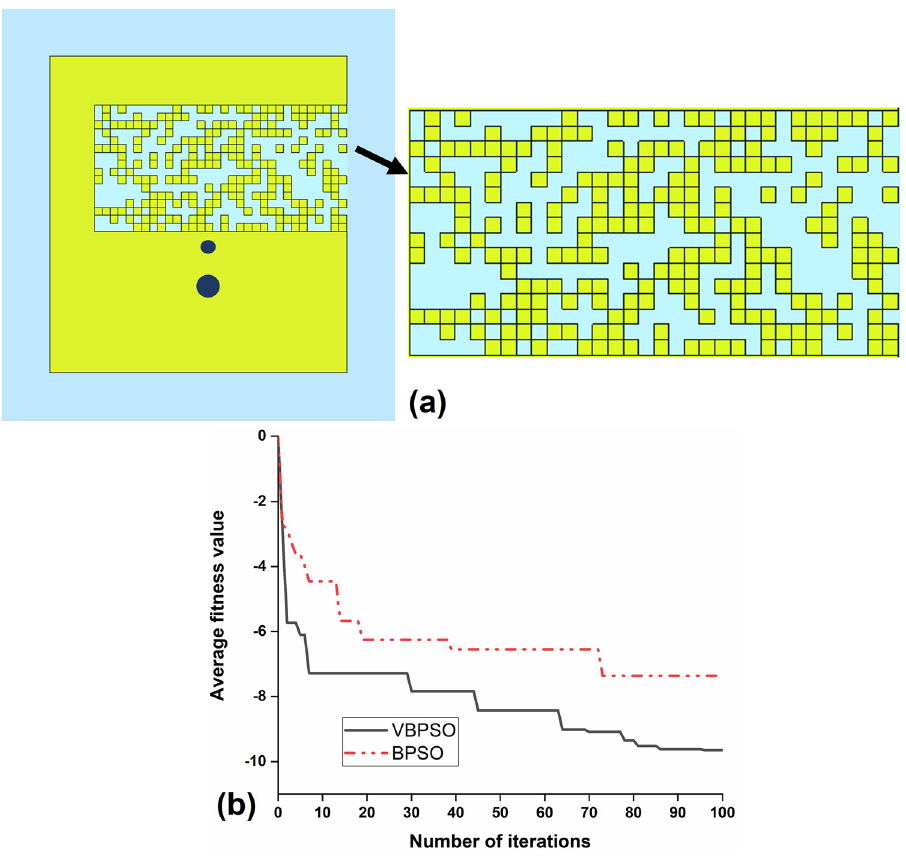
Figure 10. ( a ) Final PDG layout of the proposed antenna (Antenna D), Software used: CST Microwave Studio 2019; ( b ) Comparison of convergence curves obtained by using VBPSO and BPSO.